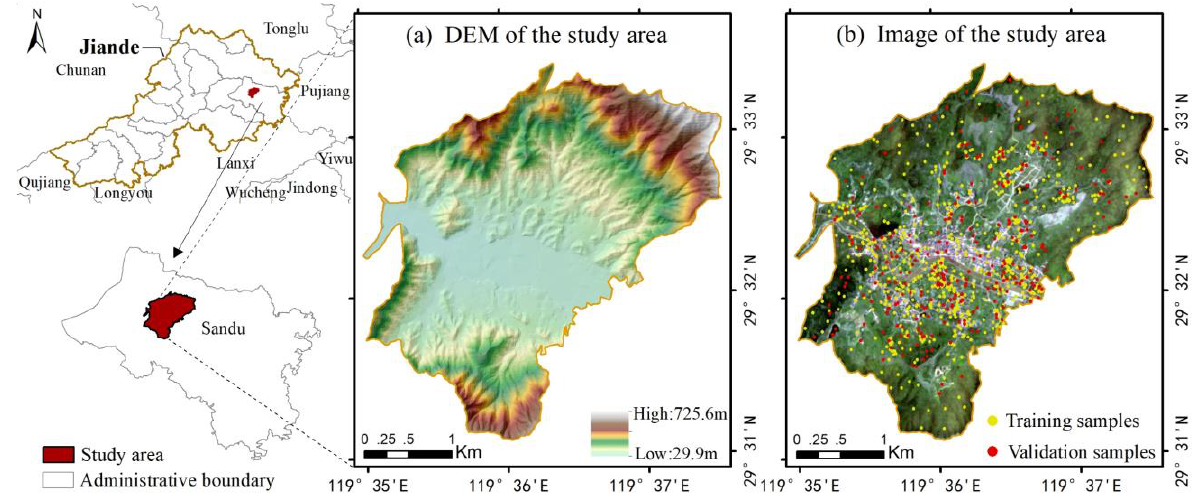
Figure 1. Location of the study area and sampling points.